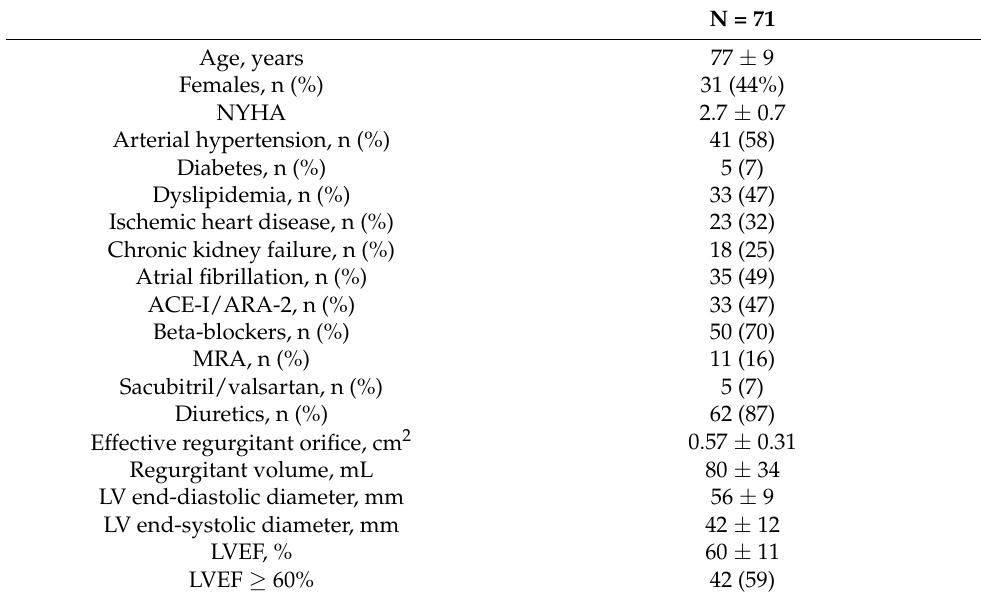
Table 1. Baseline clinical characteristics of the